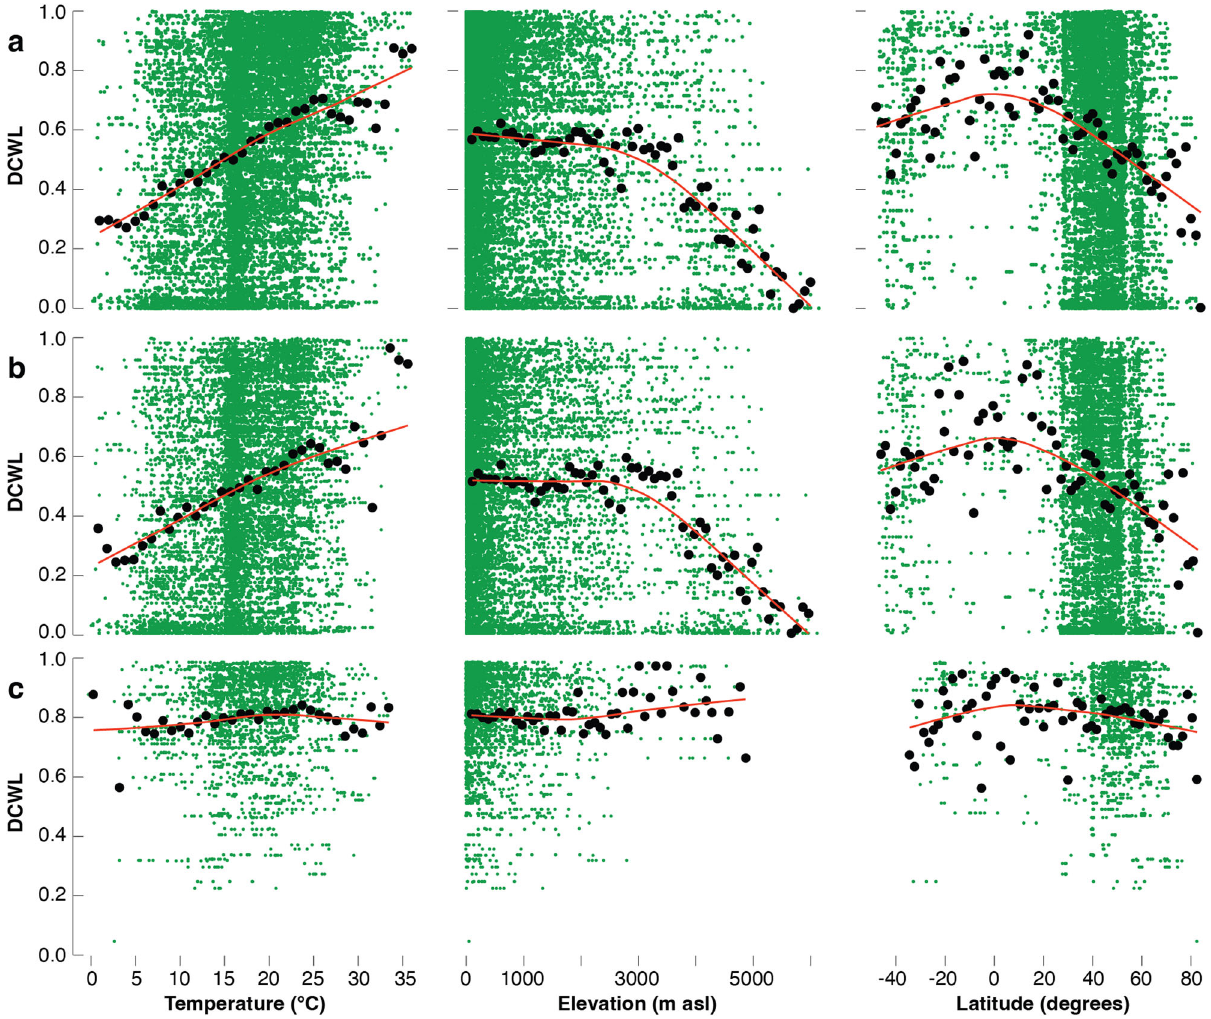
Fig. 5 The in fl uence of temperature, elevation and latitude on plant cell wall ligni fi cation. The role temperature, elevation and latitude play for DCWL in a all species, b herbs and c trees and shrubs (black dots), with the red lines being locally weighted polynomial Loess Regressions fi tted to mean DCWL values. Green dots represent species-site combinations, while black dots are mean values of DCWL computed in each class of 1 °C temperature of the warmest quarter, of 100 m elevation, and of 2° latitude. Similar results are obtained when plotting the data separately for specimens collected in natural growing conditions, in botanic gardens, and for herbs smaller than 10 cm in vertical height (Supplementary Fig.